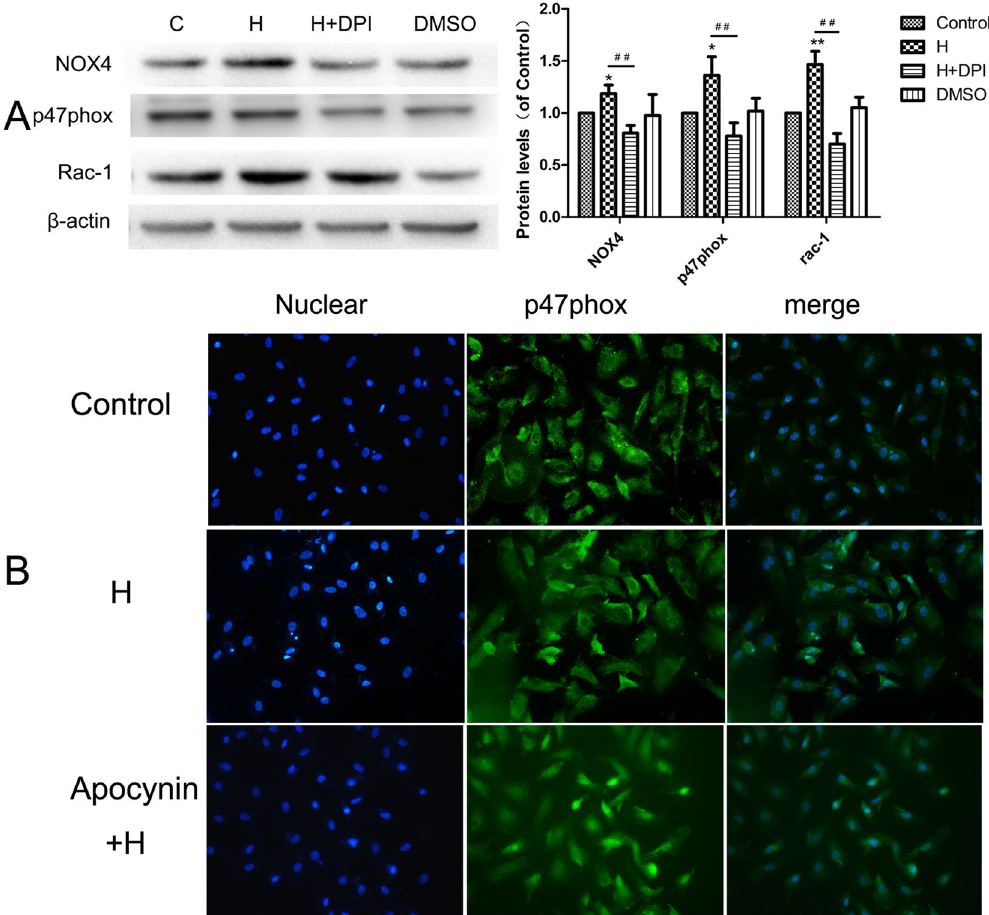
Figure 5. DPI and Apovynin pretreatment attenuated NOX4, p47phox and Rac-1 expression and p47phox translocation. DPI decreased NOX4, p47phox and Rac-1 expression ( A ). Apocynin decreased p47phox translocation induced by high glucose ( B ). Data are shown as the mean ± SEM, n = 5 independent experiments. * P < 0.05 vs control, ** P < 0.01 vs control, ## P < 0.01 vs high